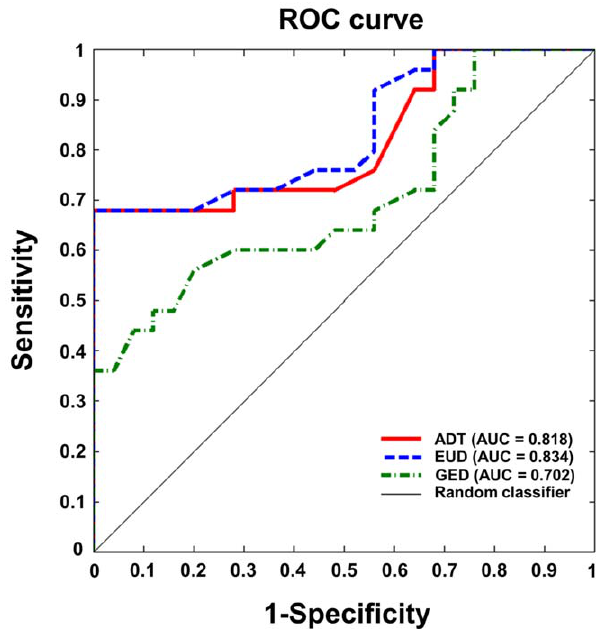
Figure 8. ROC curve results. ROC curves are plots of sensitivity and specificity of algorithms for distinguishing normal controls from patients with mild AD. AUCs are added in the figure.